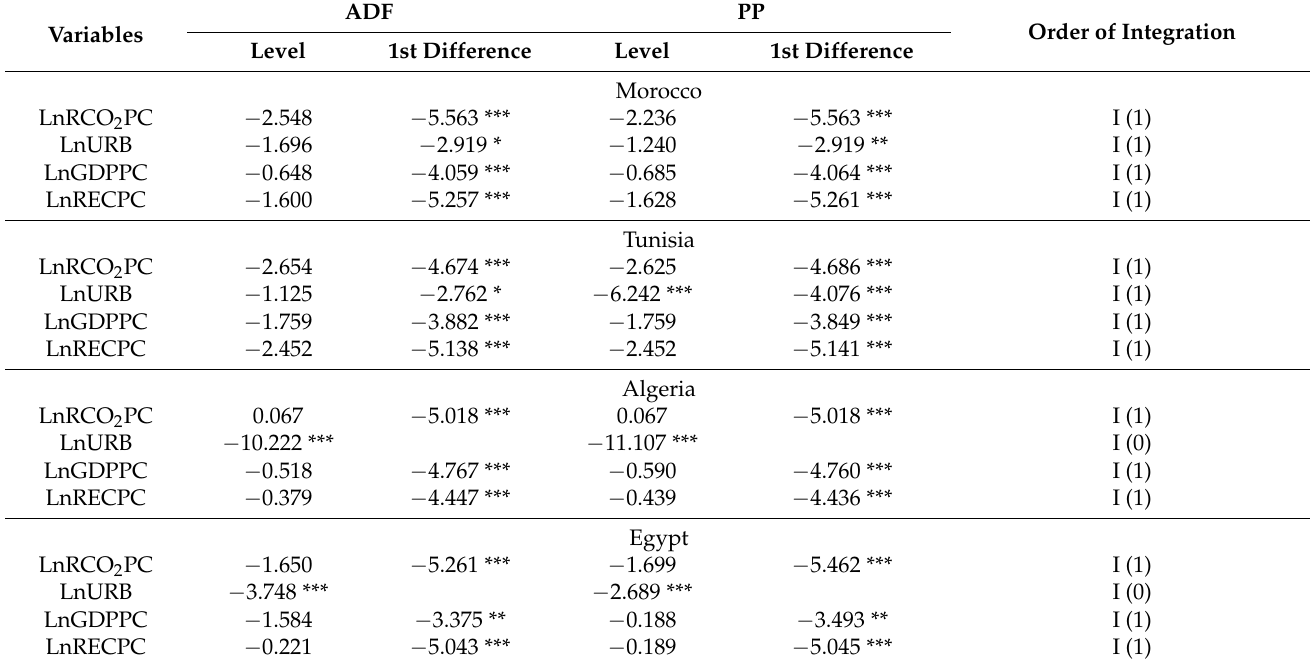
Table 3. Unit root test results for different